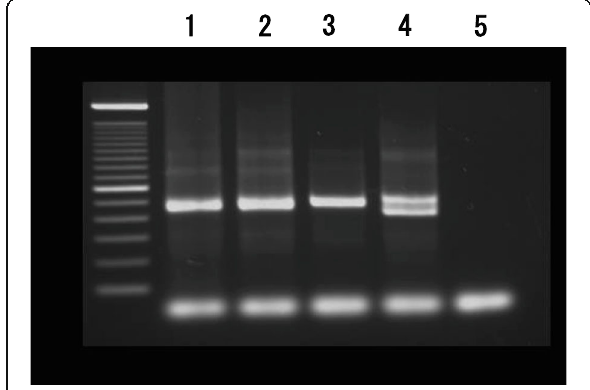
Fig. 3 Polymerase chain reaction results. Amplified DNA extracted from a skin sample is positive (lane 1). The positive control samples with Leishmania tropica DNA, L. major DNA, and L. donovani DNA are shown in lanes 2, 3, and 4, respectively, and the negative